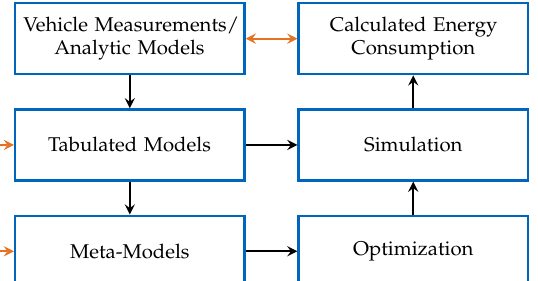
Figure 3. Overview of the parameterization, optimization and simulation process. A detailed com- parison between vehicle measurements and calculated energy consumption as well as a comparison between the tabulated models and meta-models are presented in Sections 5.1 and 5.2,